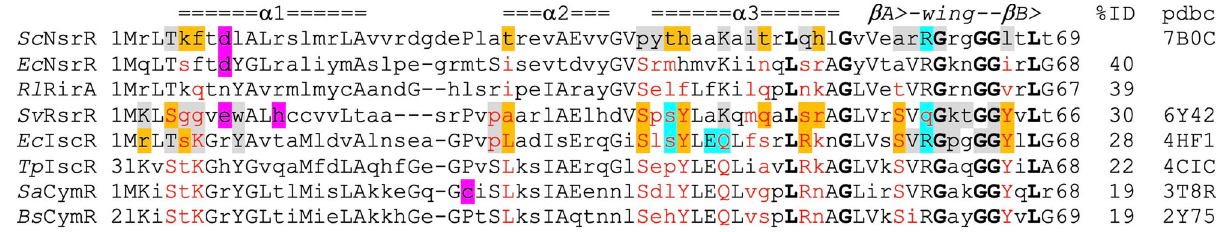
Fig. 5 H-wHTH motif sequence alignment of eight selected Rrf2 family members. Numbered α -helices (H) and labeled wing β -strands are shown on top for Sc NsrR; residues conserved in at least four sequences are indicated with capitals and given in bold when they are invariant. Percentages of sequence identity with Sc NsrR and Protein Data Bank codes for the structures used here are given in the %ID and pdbc columns, respectively. Residues with H-bond or salt bridge distances ≤ 3.3 Å to phosphate groups in the Sc NsrR/ hmpA1 , Sv RsrR/ rsrR and Ec IscR/ hyA structures are highlighted in orange and those that form H-bonds to nucleobases are depicted in turquoise; additional residues within 3.8 Å of the bound DNA fragments are highlighted in gray and those that are different from Sc NsrR are shown in red. Cluster binding residues in Sc NsrR and Sv RsrR and the oxidation-sensitive cysteine of Sa CymR are highlighted in purple. Abbreviations for different bacteria are de fi ned in the text. Tp , Sa , and Bs are Gram-positive bacteria, all the others are